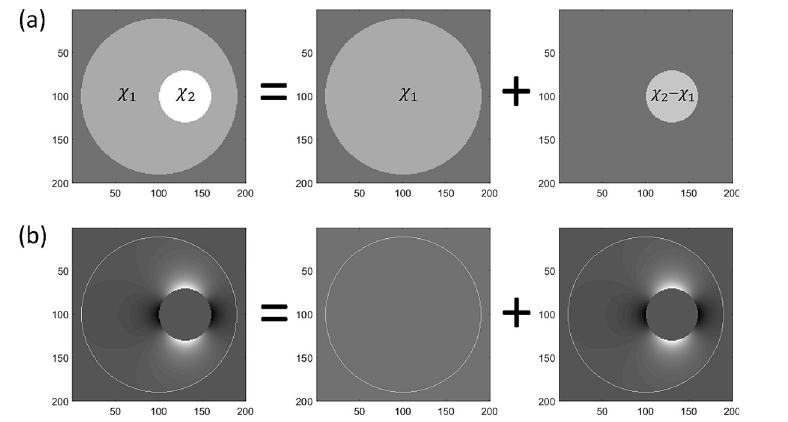
Fig 1. Phase shift in nested spheres. (a) Nested sphere as the superposition of two homogeneous spheres. (b) Corresponding phase shift maps.